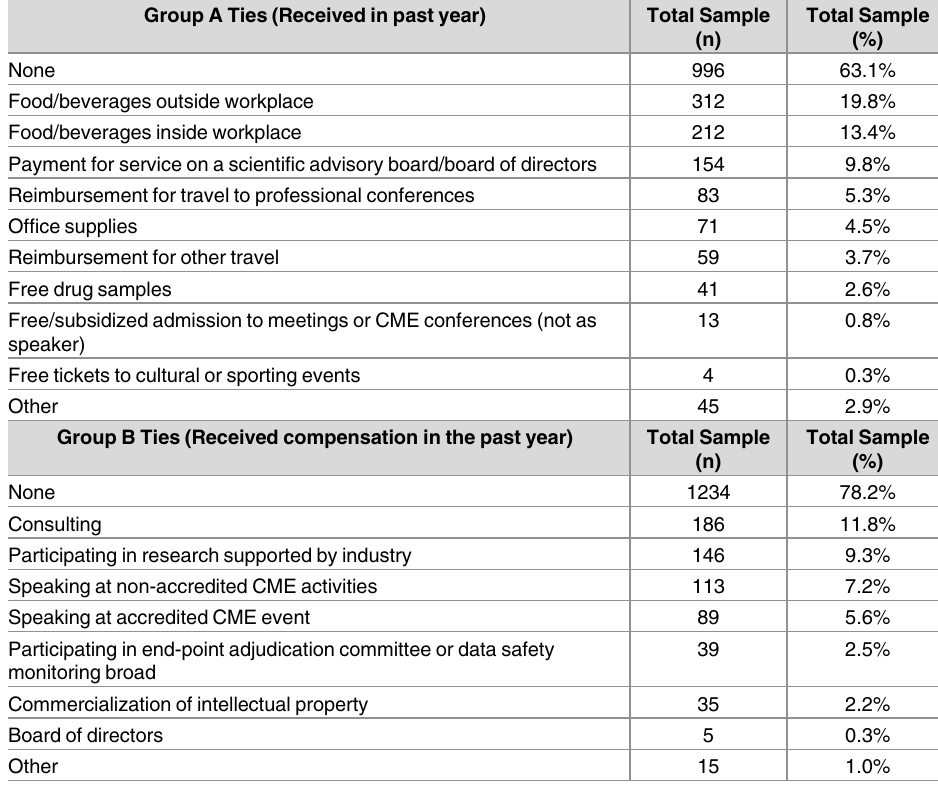
Table 4. Description of respondents’ financial ties with industry (n =